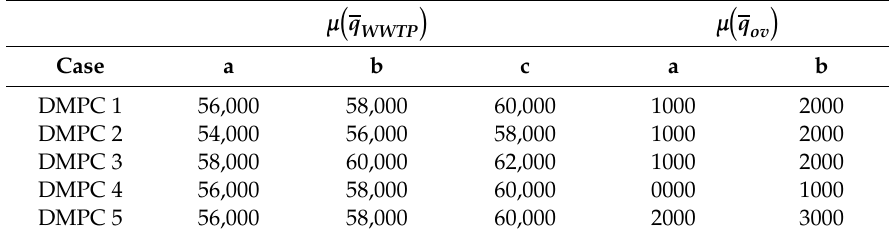
Table 7. Fuzzy sets definition for di ff erent DMPC cases.